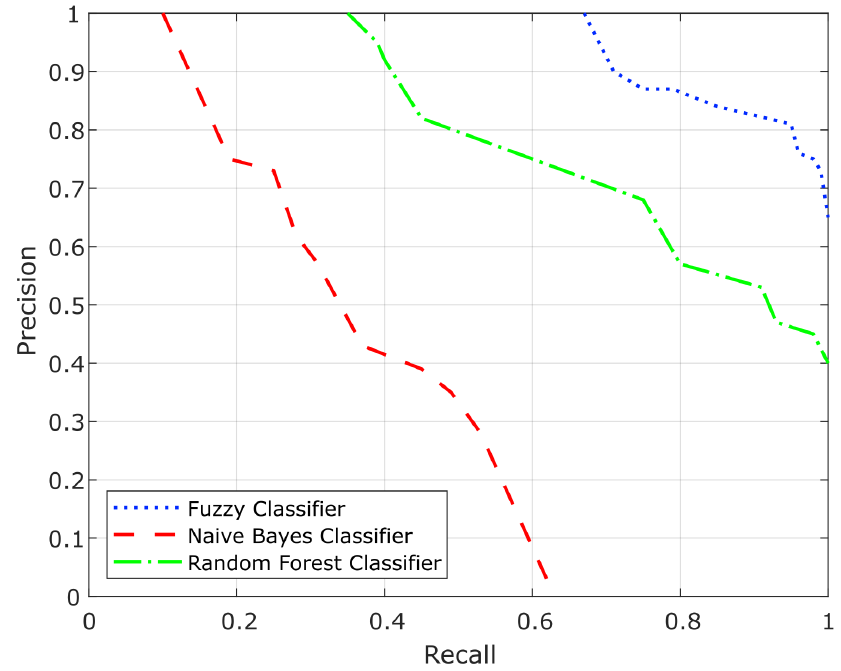
Figure 7. Precision vs. Recall curves for the Fuzzy classifier, the Random Forest classifier, and the Naive Bayes